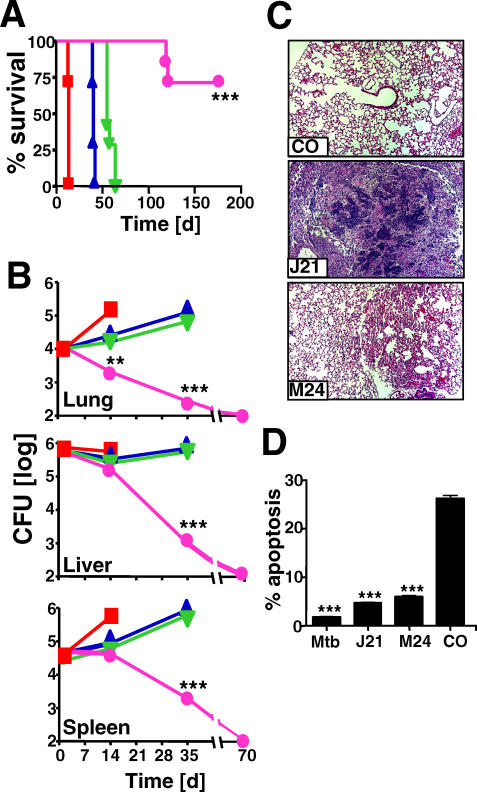
Correlation between Apoptosis Inhibition and Mycobacterial Virulence(A and B) SCID mice were infected intravenously with 106 bacteria and survival ([A], n = 7 per group), or the bacterial load in lung, liver, and spleen ([B], n = 3 per time point), were determined. Shown are results with Mtb (squares), Mkan-J21 (triangle), Mkan-M24 (inverted triangle), and Mkan-CO (circle).(C) Histopathology (hematoxylin and eosin staining) of lungs from SCID mice infected 5 wk earlier with Mkan-CO, Mkan-J21, or Mkan-M24 as indicated.(D) Levels of apoptosis in vivo after 2 wk of infection were determined by quantification of TUNEL-positive cells per total cell nuclei in lung tissue sections. Means ±SD for blinded analysis of about 2,000 total cells per tissue section (three sections per lung) per mouse (n = 3) are shown. The results shown are representative of three independent experiments. Error bars representing ±SD are shown in (D) and are smaller than symbols in (B).Asterisks indicate p-values as in Figure 1.